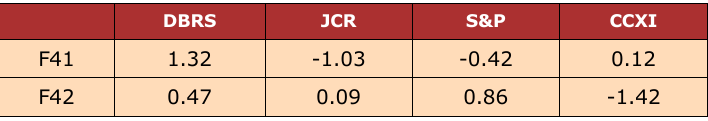
Table 10. the Scores of Principal Component (3)